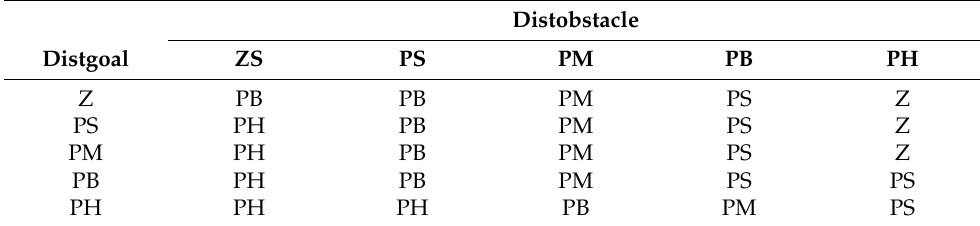
Table 3. Fuzzy control rules of Distgoal, Distobstacle, and ε obstacle .